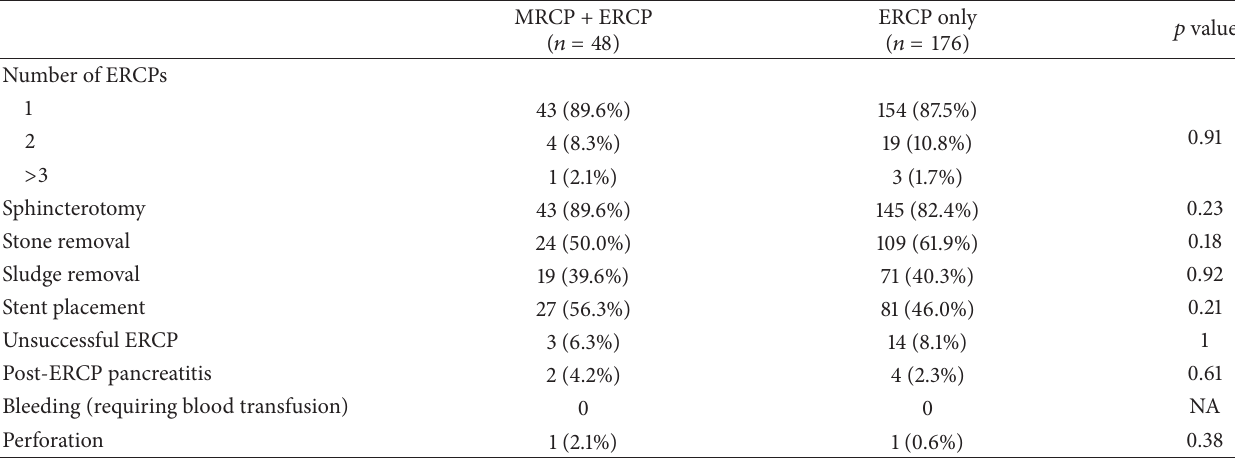
Table 2: Procedural characteristics and complications of patients at high risk of choledocholithiasis. MRCP +